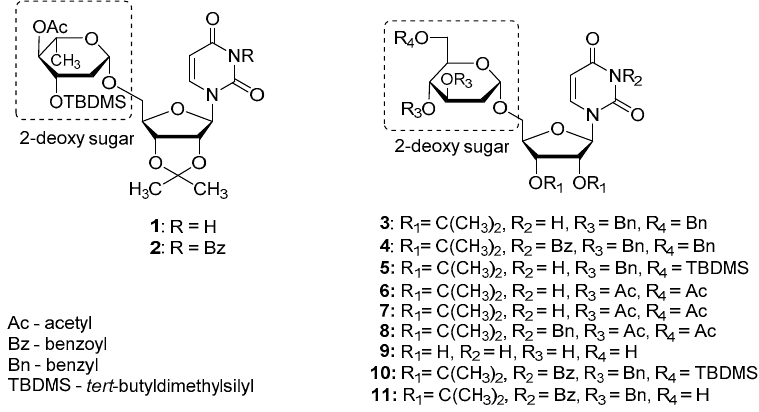
Figure 1. The structures of uridine derivatives of 2-deoxy sugars used in the study: 1 – 11.